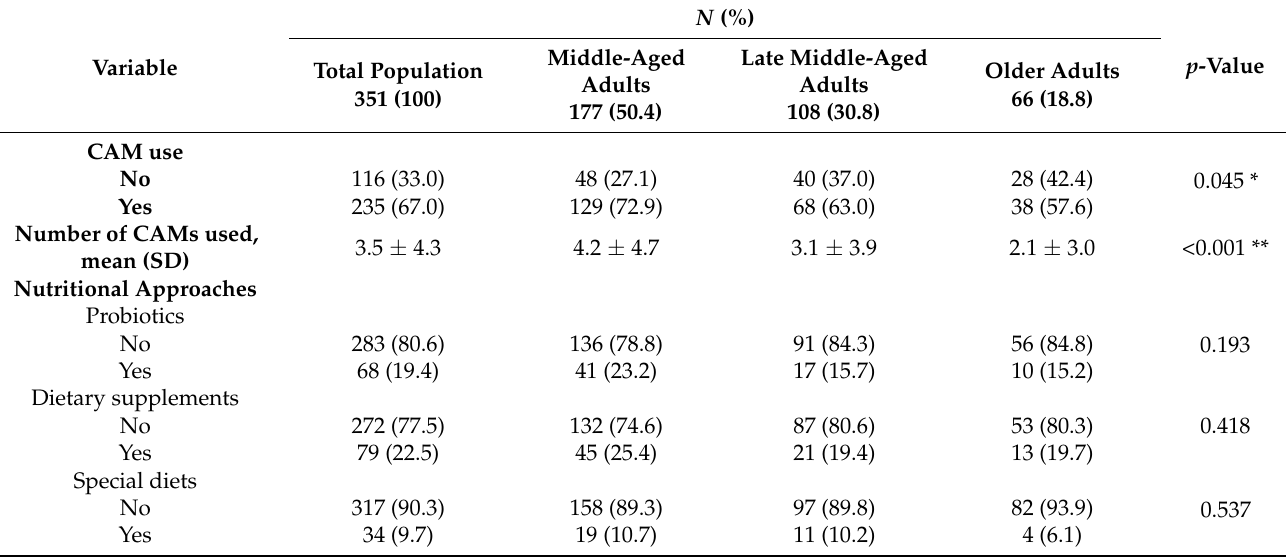
Table 3. Comparison of the prevalence of using different complementary and alternative medicines (CAMs) for relieving stress in study participants ( N =